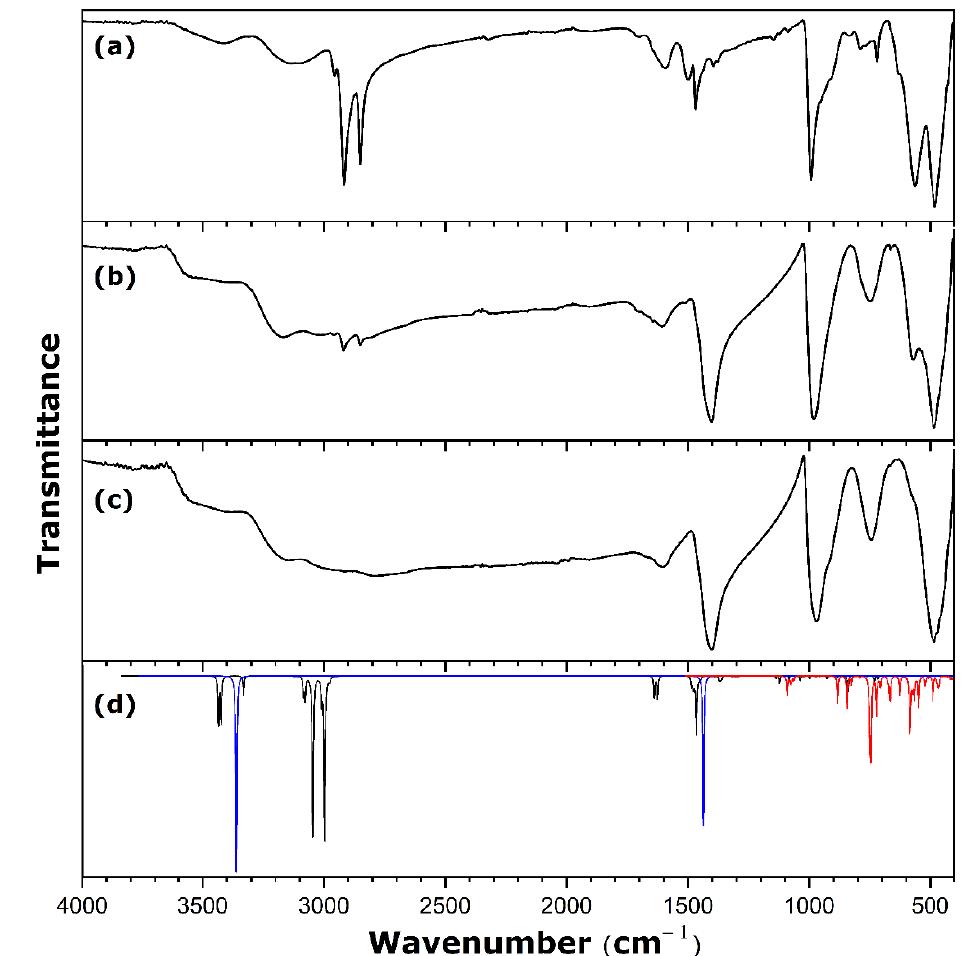
Figure 5. Experimental infra-red spectra of the pristine and exchanged samples: ( a ) hybrid hexadecylamine-vanadium oxide material, VO x -C16, ( b ) pristine sample after one exchange with NH 4+ , ( c ) pristine sample after two-stage exchange with NH 4+ , ( d ) simulated IR spectra of protonated amine cation (black line), NH 4+ ion (blue line), and model vanadium oxide structure containing NH 4+ (red line).